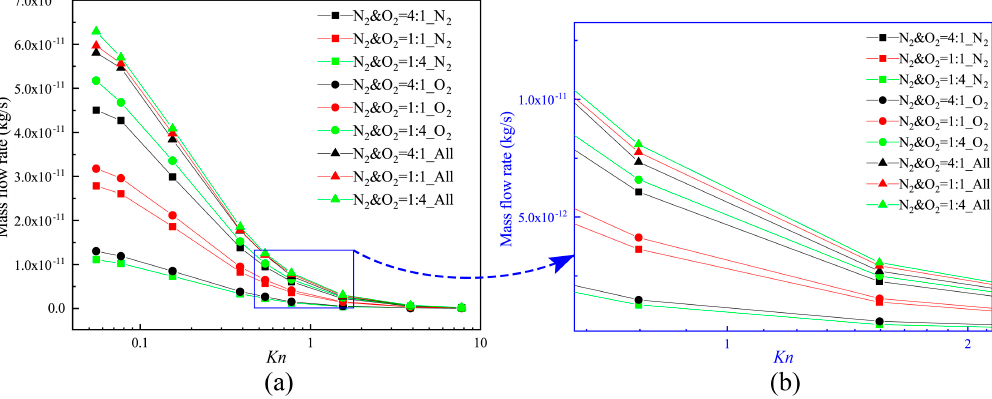
Figure 8. Mass flow rates for different Knudsen numbers.